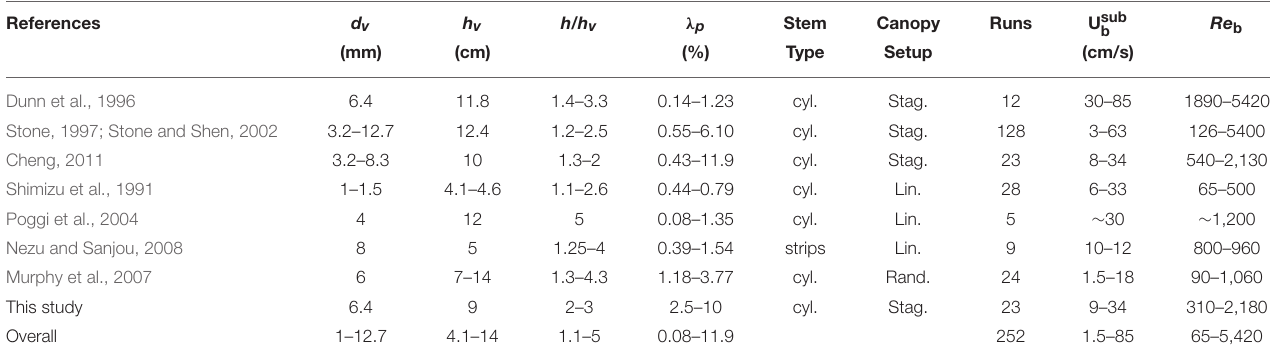
TABLE 3 | Overview of experimental studies on drag in submerged rigid canopies from which data was obtained.